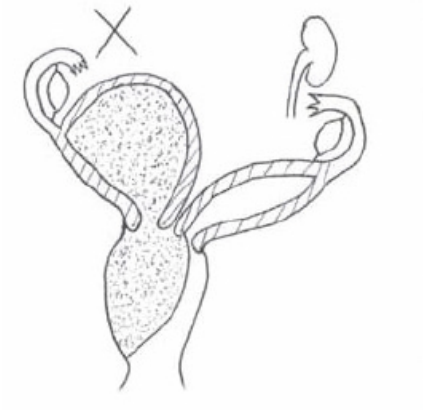
Figure 1: Genital malformation with uterus didelphys and right renal agenesis characteristic of the